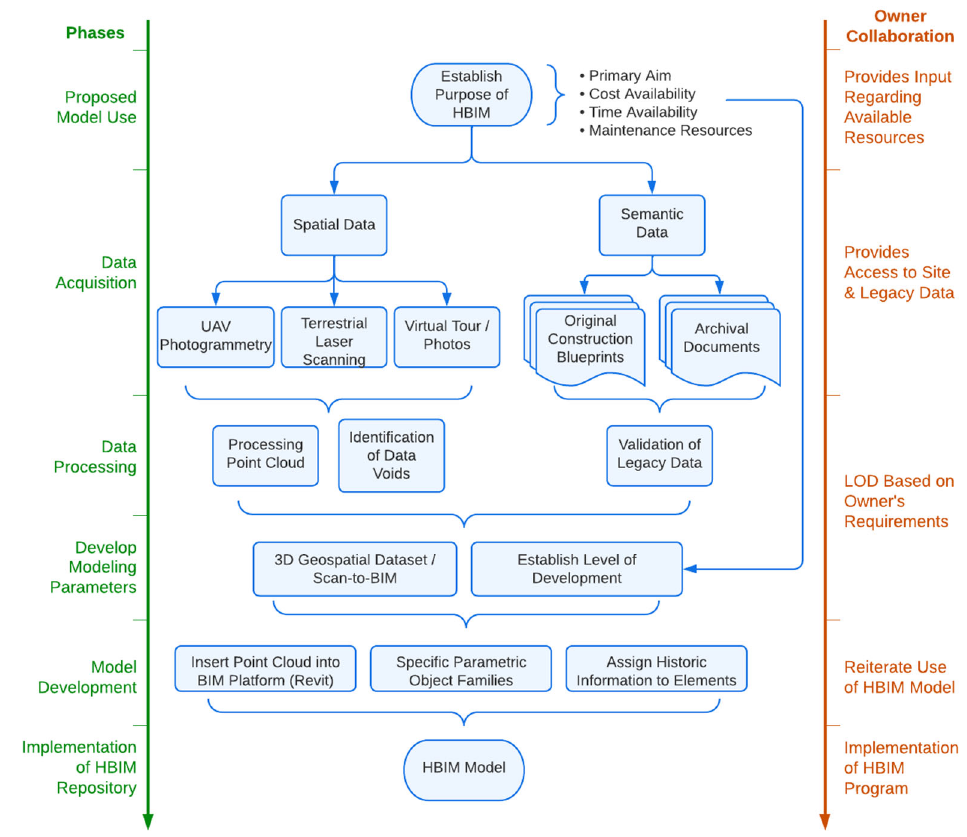
Figure 10. Methodology used in the HBIM program case study of the OPCC.